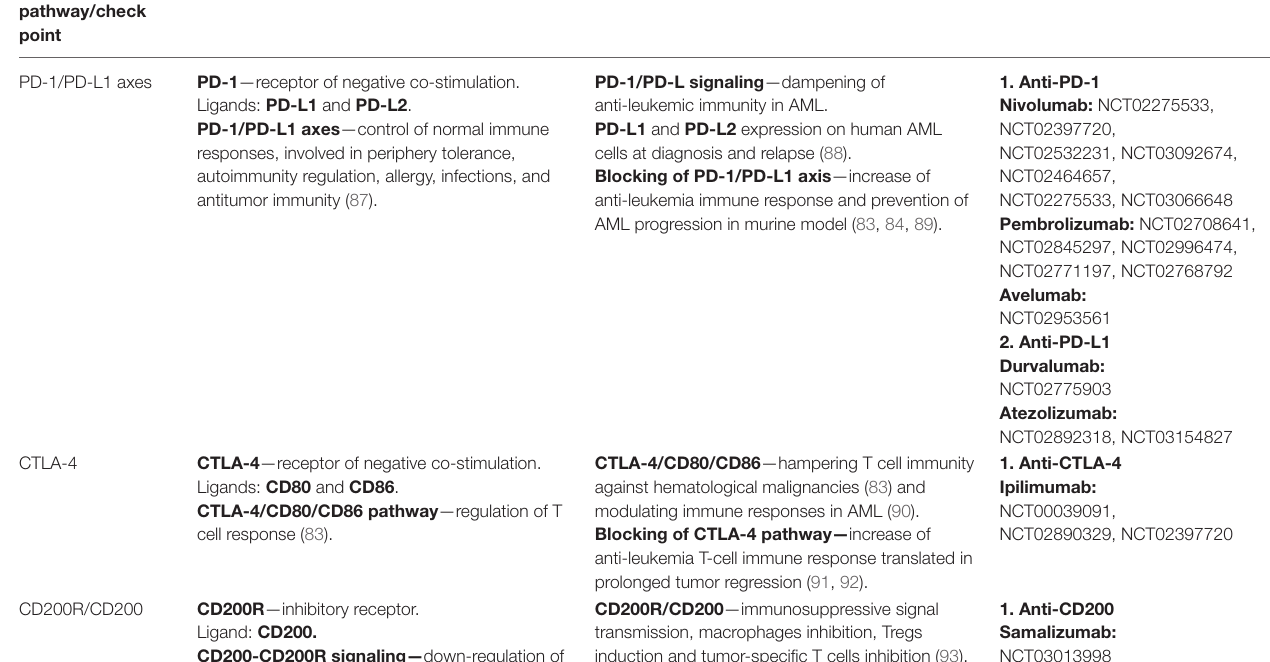
TABLE 1 | Inhibitory pathways in AML. Inhibitory Physiological role Role in AML pathway/check point PD-1/PD-L1